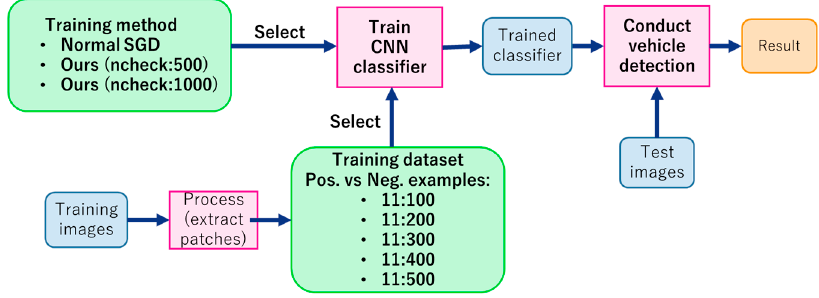
Figure 8. Experiment overview.